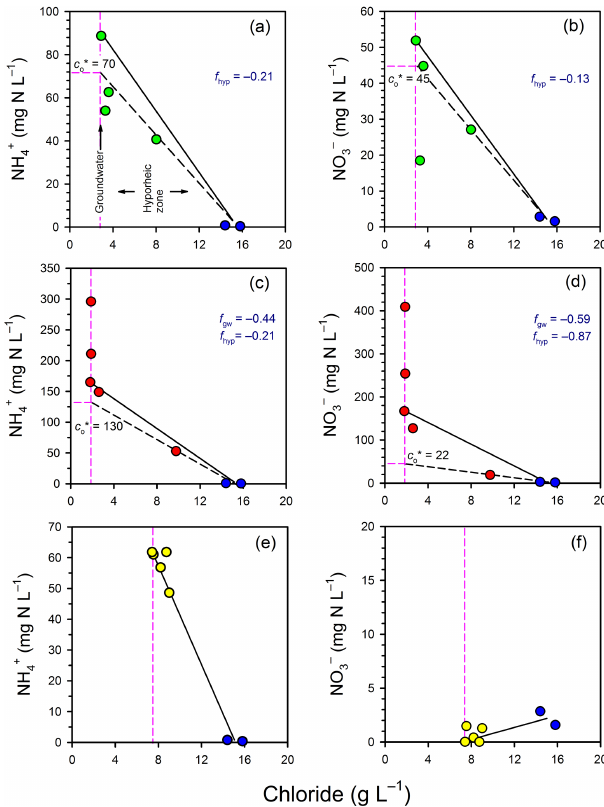
(a, c, 4 Figure 6. Evaluation of mixing and transformations for δ 15 N NO (a, c, e) and δ 18 O NO (b, d, f) for Profile 1 (a, b) , 3 3 Profile 2 (c, d) and Profile 3 (e, f) . The vertical pink lines represent samples collected in the groundwater zone and those to the right of this line are within the hyporheic zone, based on chloride con- centrations. The blue circles represent the surface water samples. The black solid lines represent expected isotopic values if only conservative mixing occurred in the hyporheic zone. The red arrows indicate the position of samples in the profiles (from bottom to top), highlighting an apparent reversal in the path of isotopic enrichment for NO − at the base of the hyporheic 3